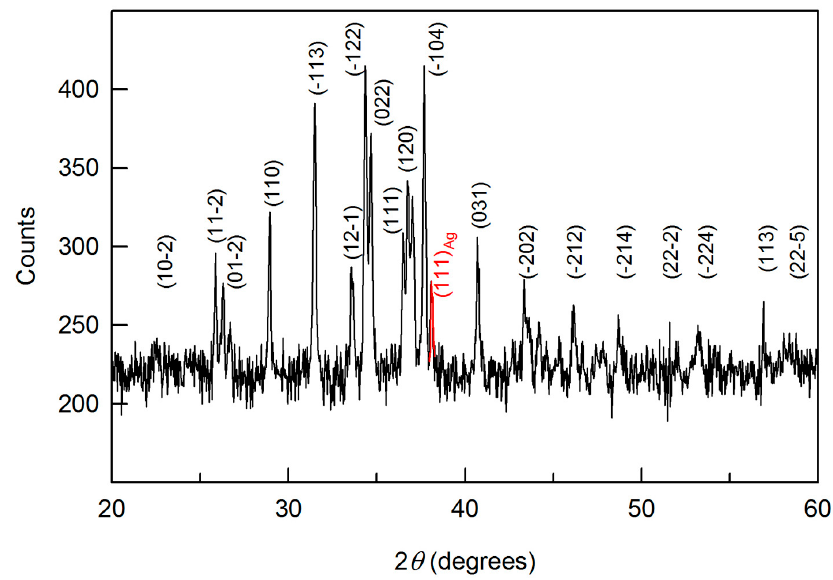
Figure 8. Experimental XRD pattern of Ag 2 S pressed pill registered at 298 K after heating to 893 K. Diffraction reflection (111) Ag of metallic silver Ag is shown by red color.